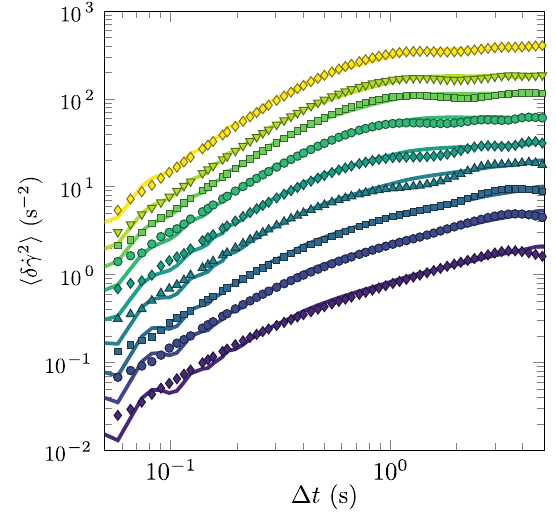
FIG. 12. Variance h δ _ γ 2 ið Δ t Þ of the shear rate for various imposed stresses (colored symbols) together with the fits by linear combinations of h δ _ γ 2 and h δ _ γ 2 as detailed in the main text q i p i (colored lines). The coefficients α and β used for the fits are shown in Fig. 5(c). For clarity, successive data sets were shifted vertically by 2 starting from σ ¼ 13